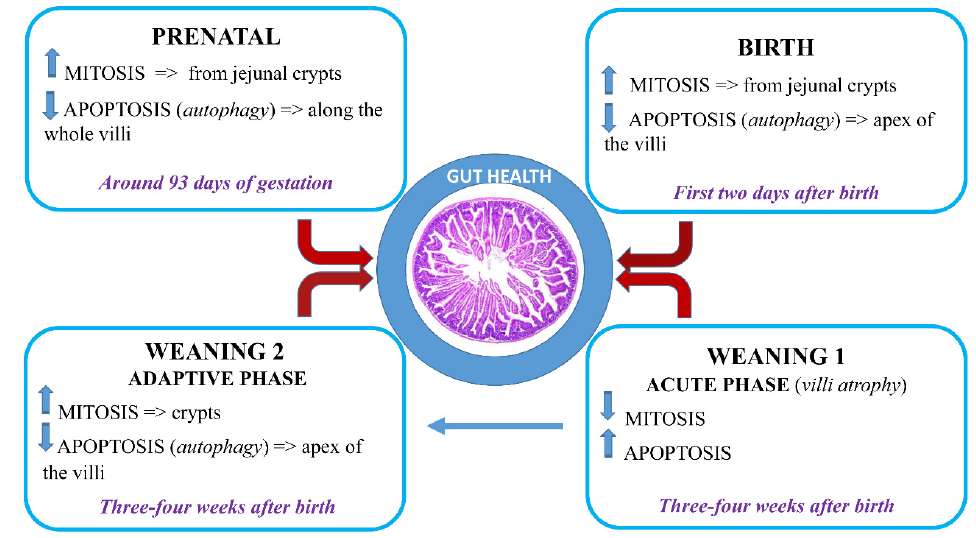
Figure 1. Timing of cellular turnover during gut development: apoptosis and mitosis. Appropriate changes of the anatomical structure of the intestinal mucosa and its en-